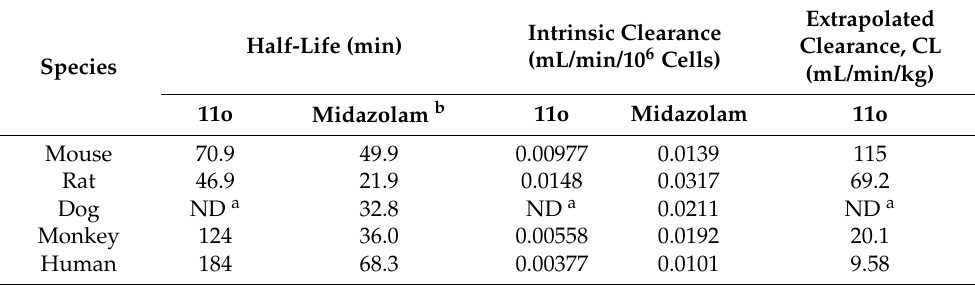
Table 3. Summary of the half-life, intrinsic clearance and extrapolated clearance values of 11o and midazolam in mouse, rat, dog, monkey and human hepatocytes.